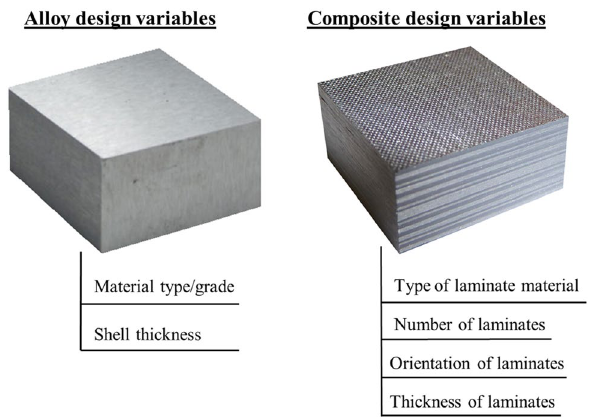
Fig. 10 The main design variables of alloys and composites. From [57]